Question: How would you classify this visualization?
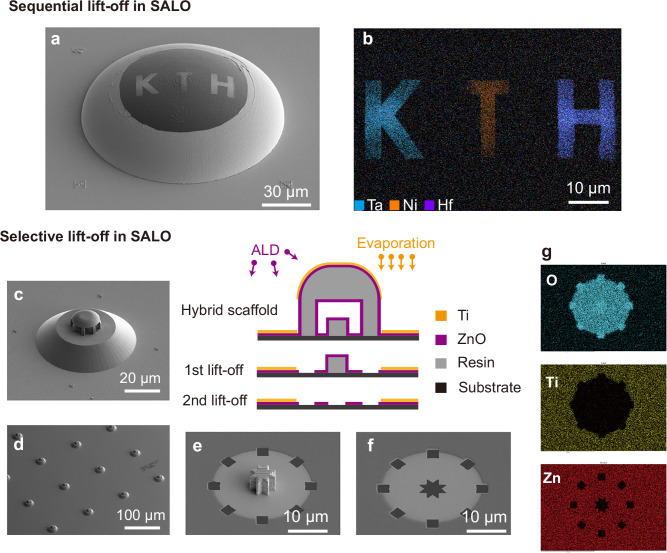
Answer: line